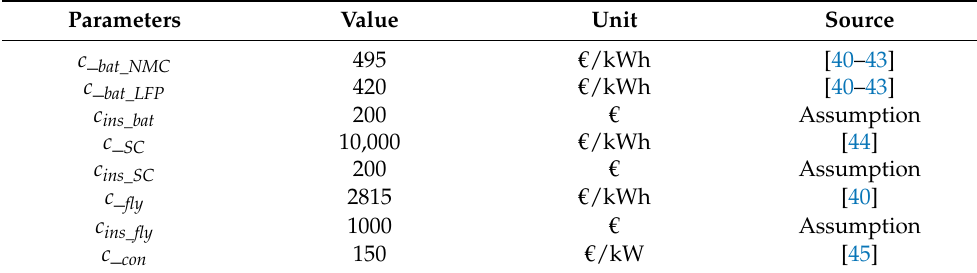
Table 4. Nominal parameters of the experimental devices.